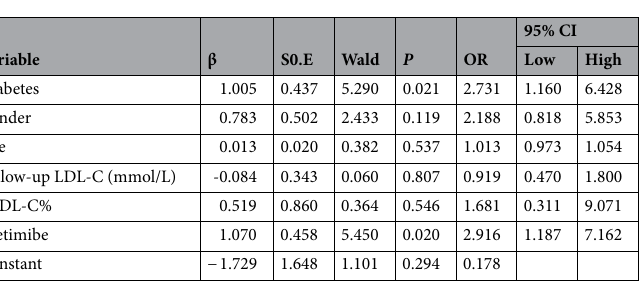
Table 4. Multivariate logistic regression analysis of factors predicting plaque progression of nCSA. CI confidence interval, LDL-C low-density lipoprotein cholesterol, OR odds ratio, PP plaque progression.